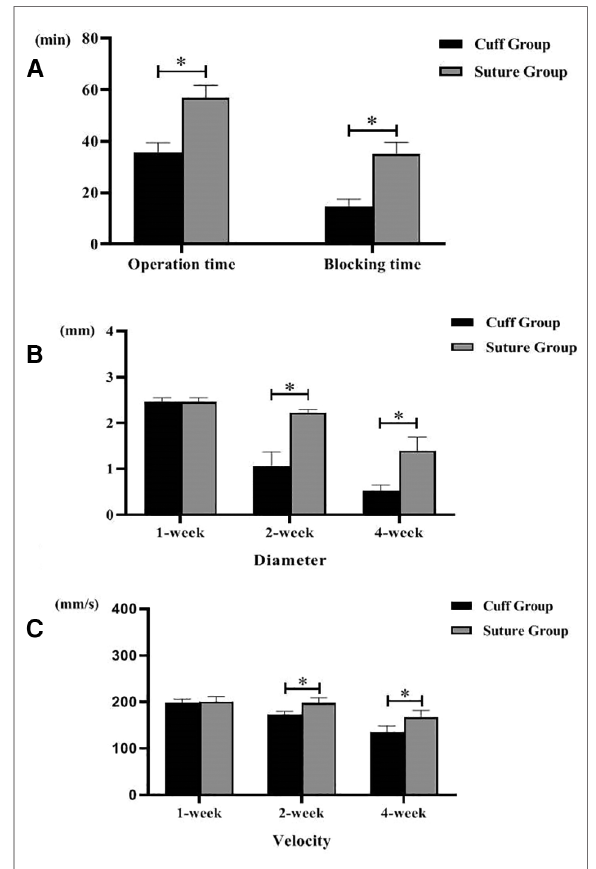
FIGURE 2 Operation time of two models of vein replacement and postoperative vascular ultrasound (* indicated statistically signi fi cant difference between the two groups). ( A ) Operation time and blood fl ow blocking time of two models. ( B ) Inner diameter of abdominal ultrasound indicating vein at different time points of two models. ( C ) Blood fl ow velocity of abdominal ultrasound indicating vein at different time points of two models. Error bars represent standard deviation of the mean.